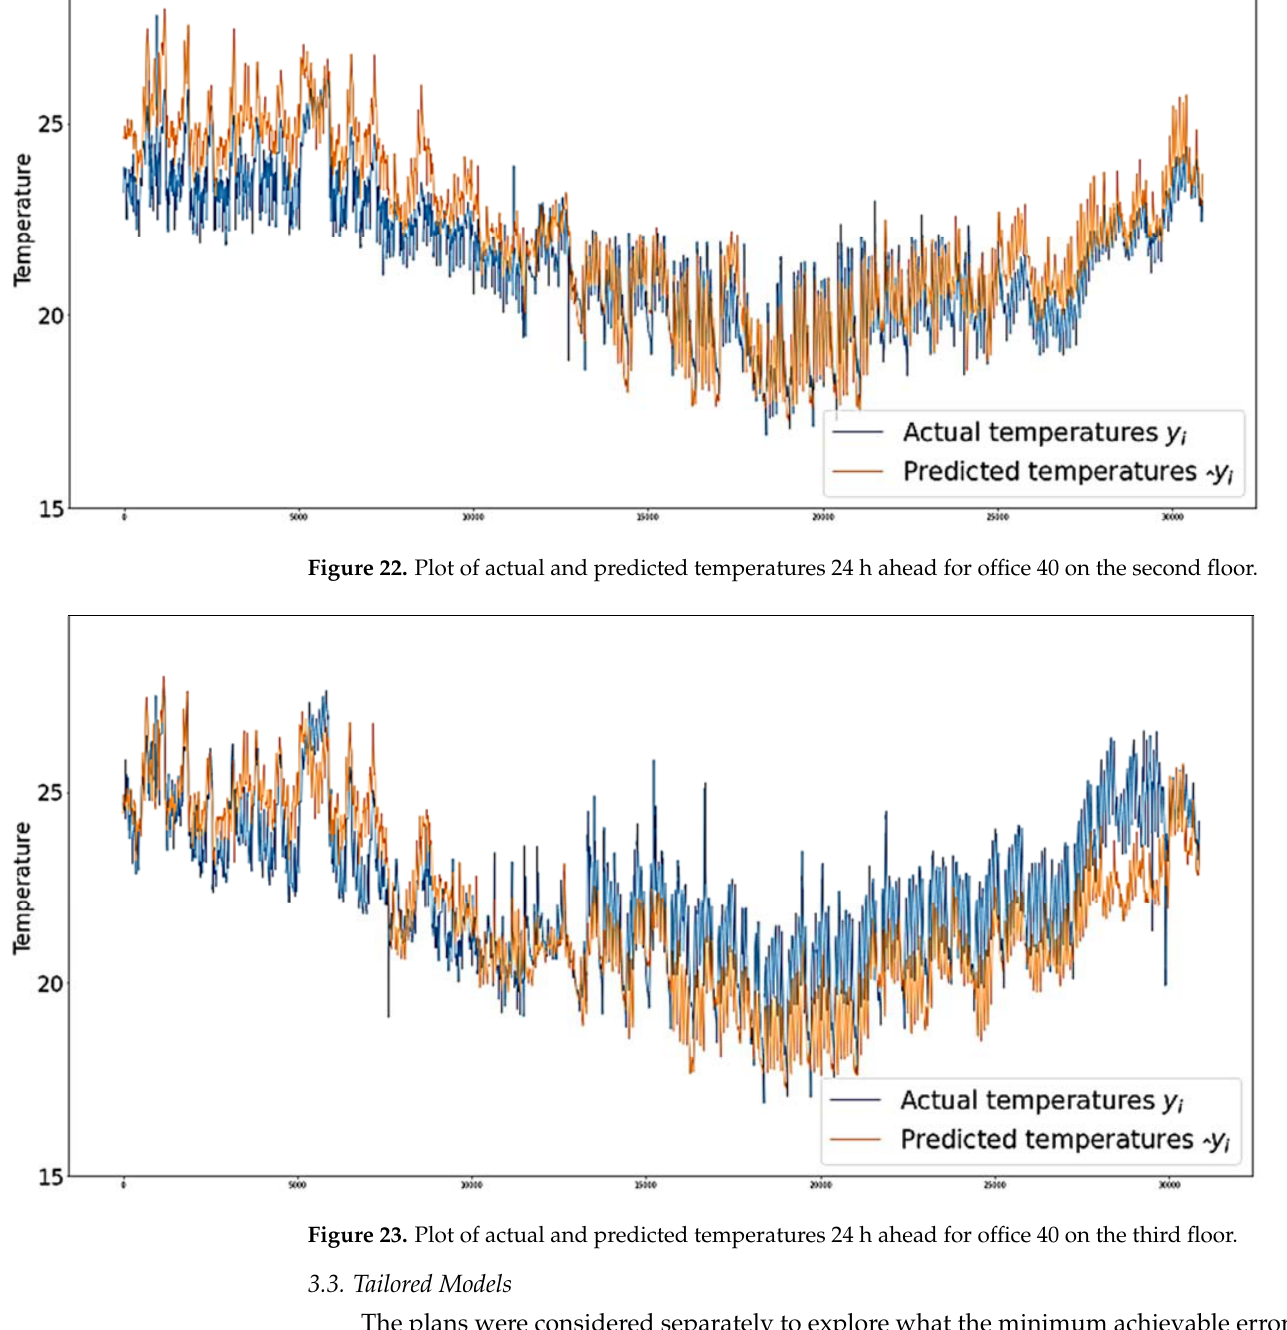
Figure 24. Average RMSE trend concerning the number of neurons in each layer for the validation set on 2 h prediction horizon. The learning rate is a significant parameter and is set at 0.00001. It is only below this threshold that the learning curves stop fluctuating and the detection of the minimum of the loss function is successful, as indicated in the previous subsection. Abandonment